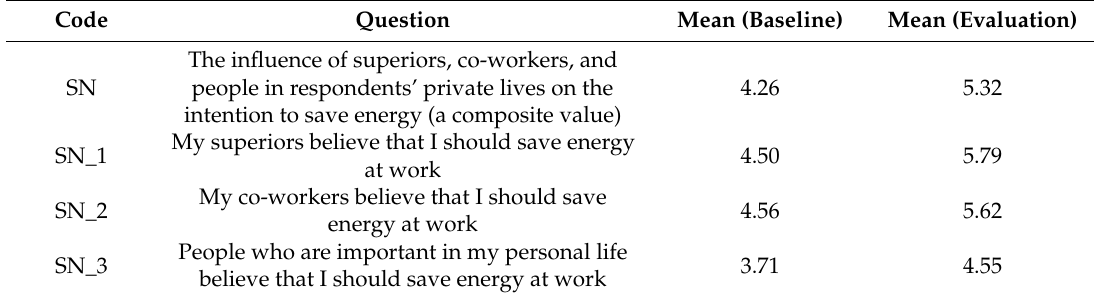
Table 9. Mean perceived subjective norm (SN) scores (totally disagree (1) to completely agree (7)). Code